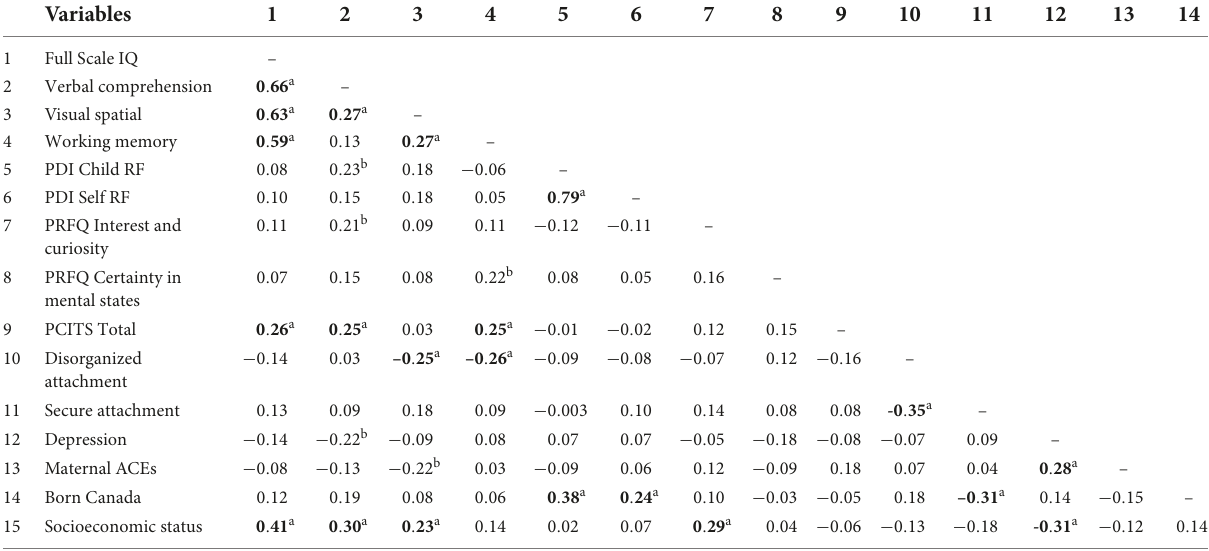
TABLE 2 Bivariate Pearson correlations with maternal and child variables ( N = 73).